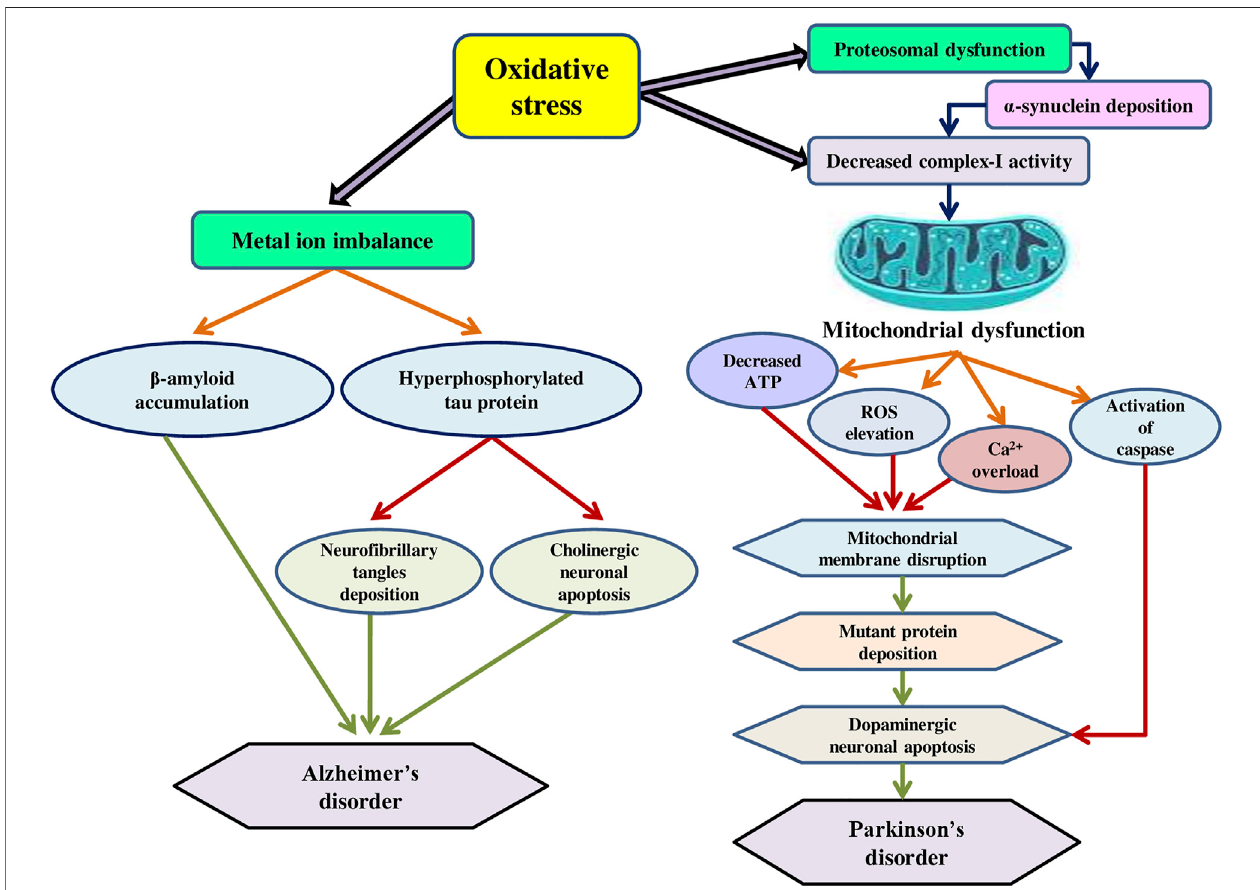
FIGURE 3 | The mechanism of mitochondrial dysfunction and oxidative stress in Alzheimer ’ s and Parkinson ’ s disorders.